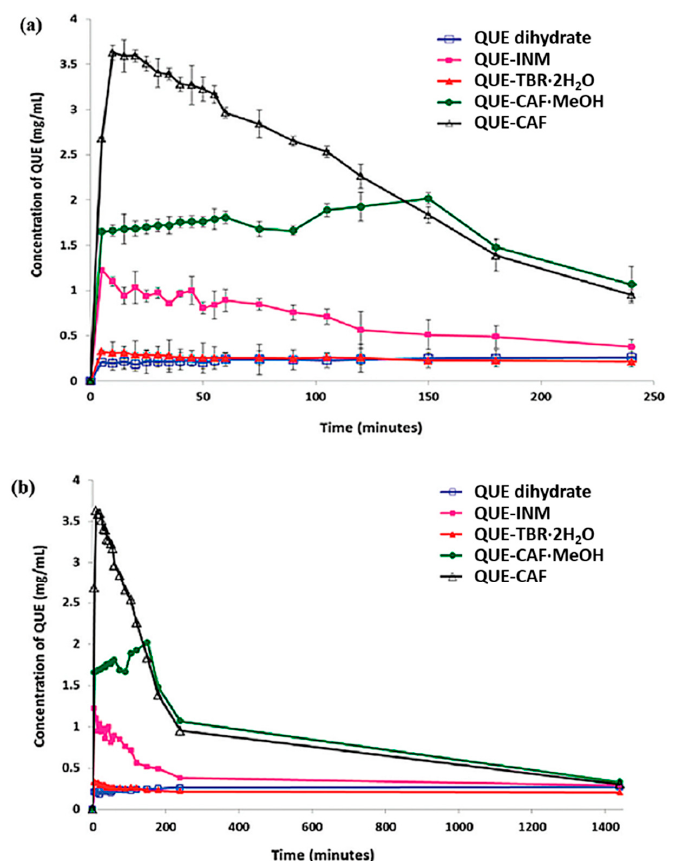
Figure 6. Dissolution profiles of QUE dihydrate and QUE cocrystals in 1:1 methanol/water mixture during ( a ) the first 4 h and ( b ) 24 h. Adapted from [52] with permission. Copyright © 2011 American Chemical Society.